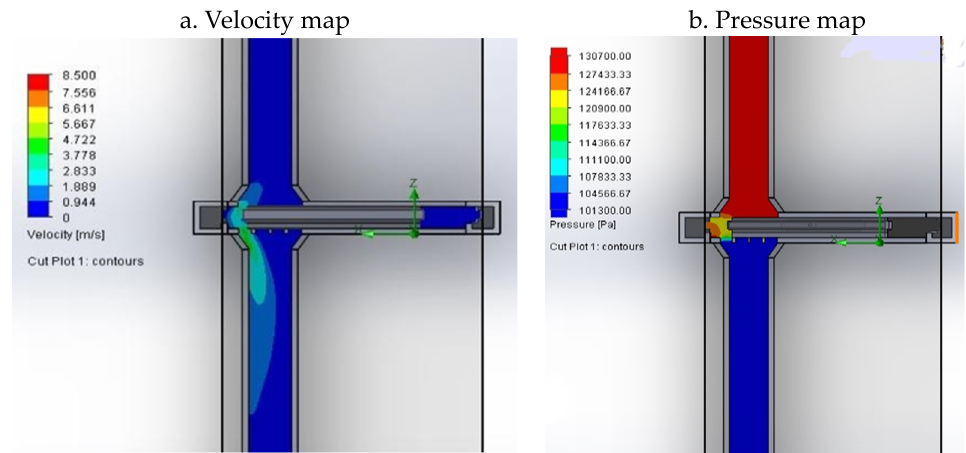
Figure 17. Third valve geometry with 10% opening.